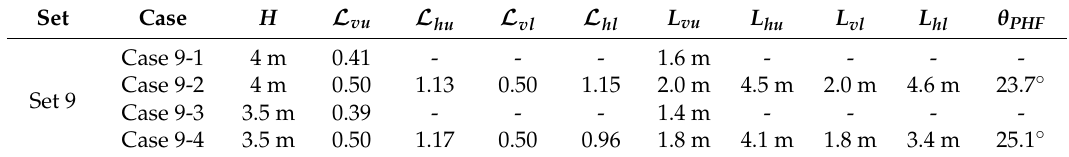
Table 14. Field scale PHF behaviors in Set 9 evaluated from laboratory scale numerical